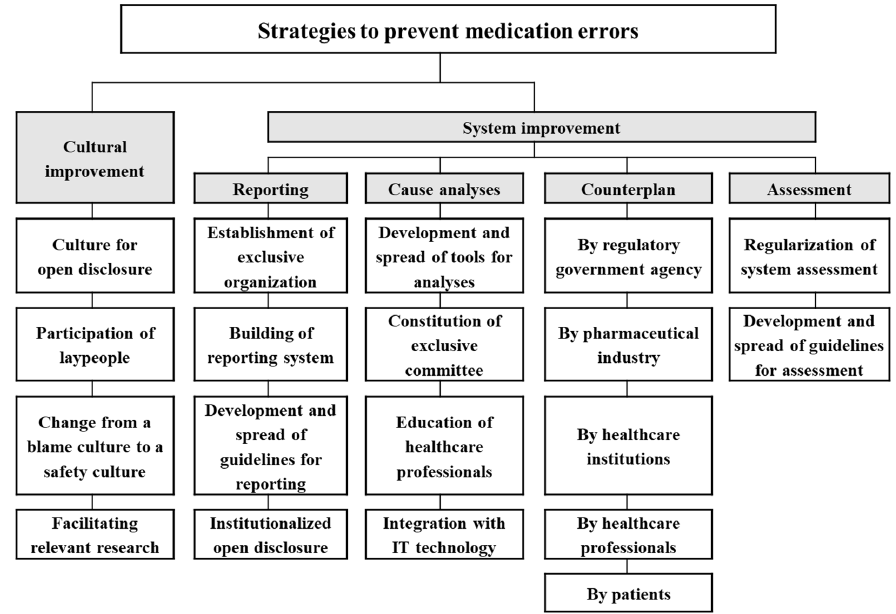
Figure 1. The hierarchy structure of strategies to prevent or reduce medication errors. Table 2. Definitions of criteria and alternatives